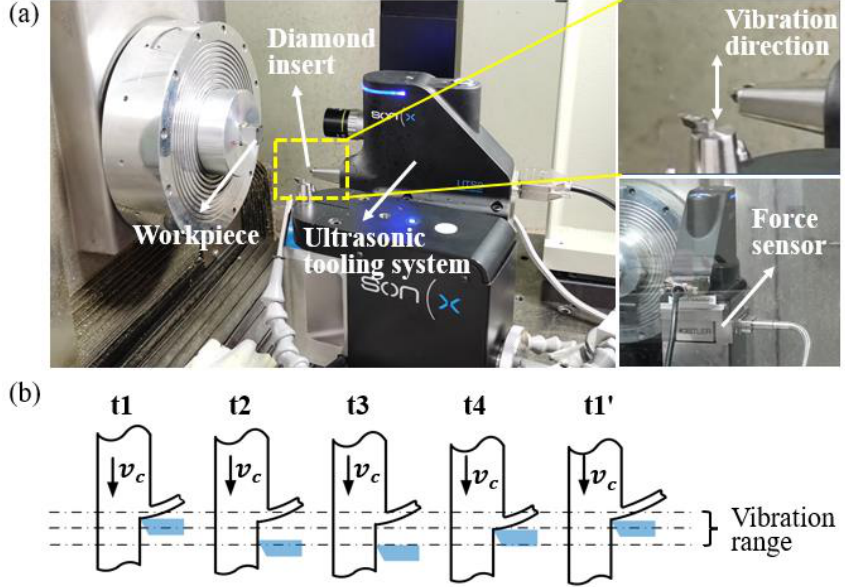
Figure 6. ( a ) A photo of the experimental setup, ( b ) a schematic of tool motion in HFUVAS.